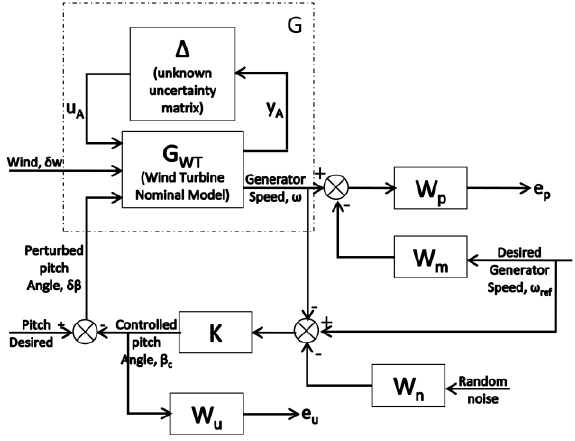
Figure 5. Interconnection structure of the closed- loop wind turbine system